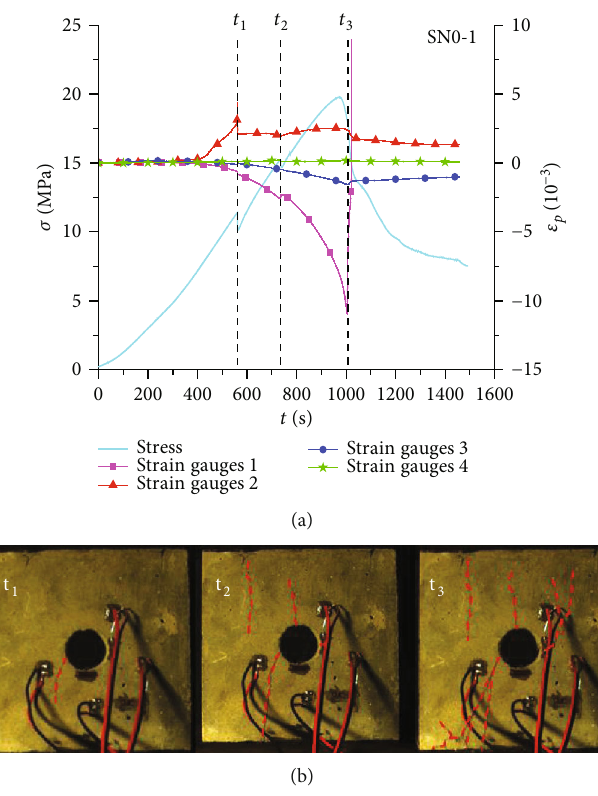
Figure 10: (a) Relationship between local strain and stress of specimen SN0-1 with loading time. (b) The relationship between the crack growth shape of specimen SN0-1 and loading